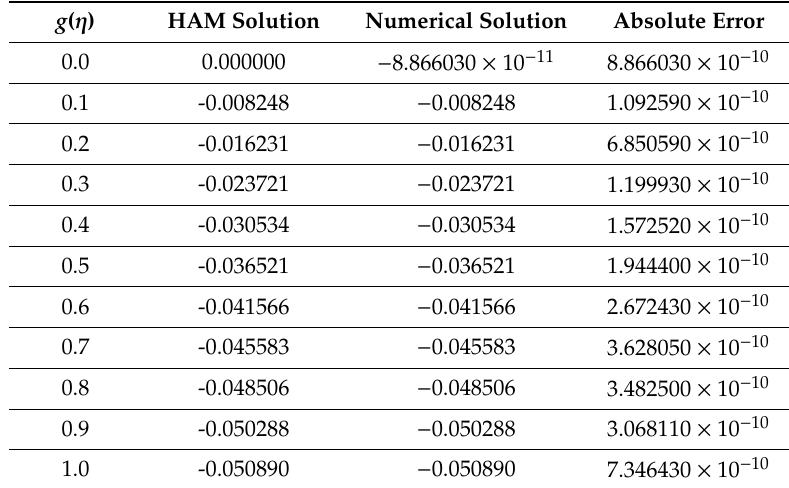
Table 3. Comparisons of the HAM and numerical solution.